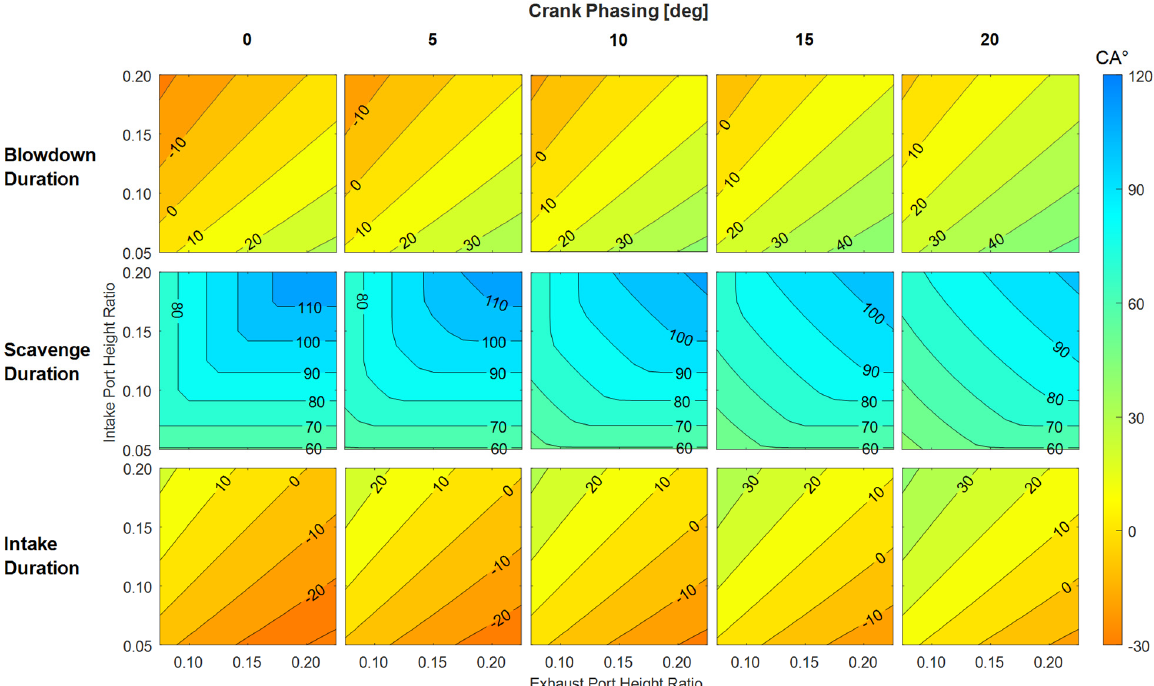
Figure 8. Impact of crankshaft phasing and intake and exhaust port height-to-stroke ratio on blowdown, scavenge and intake durations (in CA°).